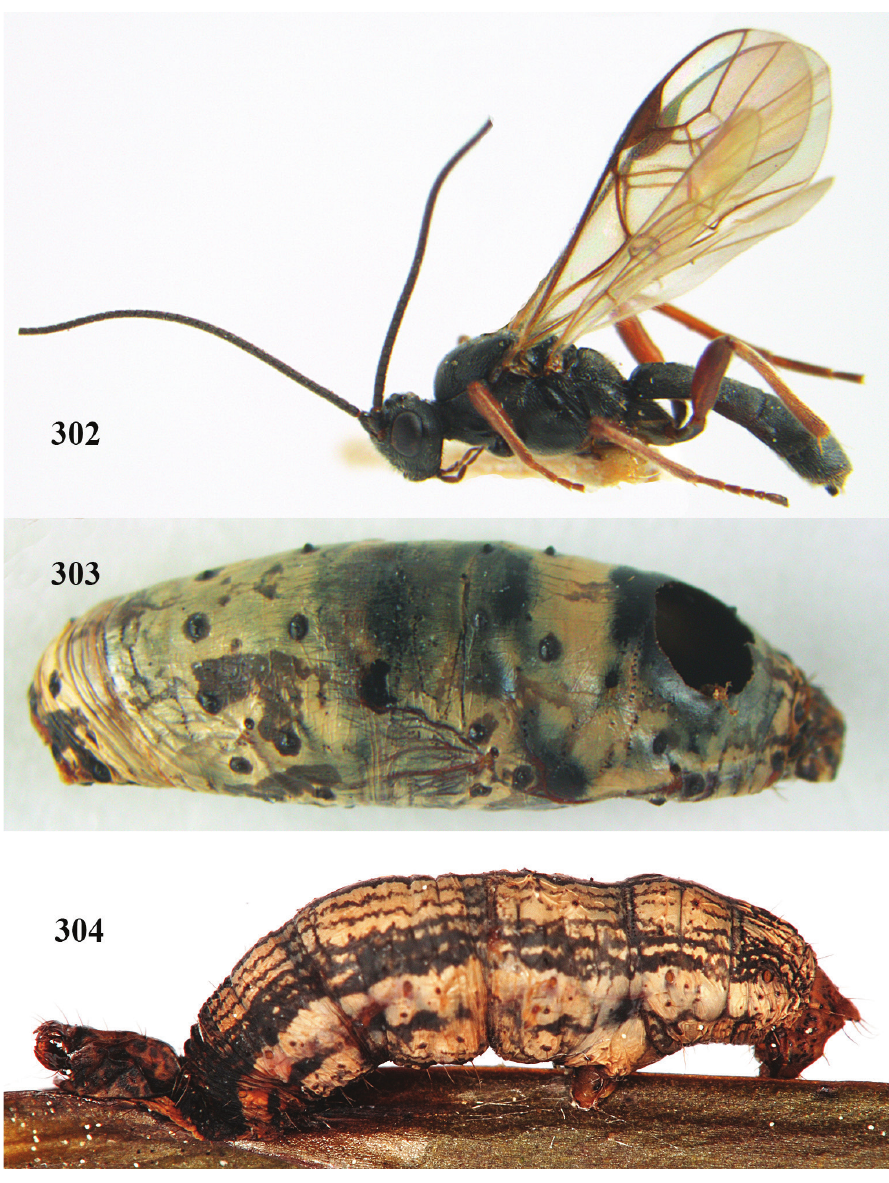
Figures 302–304. Aleiodes reticulatus (Noskiewicz), ♀ , Russia, Rostchino, but 304 from Poland. 302 habitus lateral 303 mummy of cf. Macaria wauaria (Linnaeus) 304 mummy of Macaria brunneata (Thunberg) forming, at end will resemble